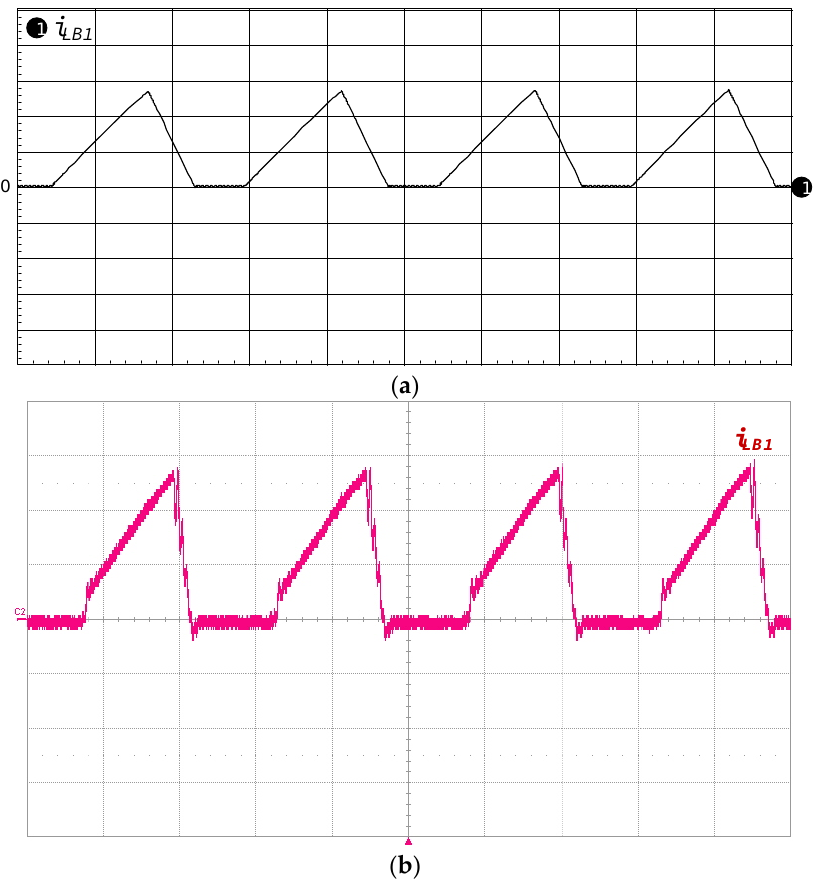
µ s/div. LB1 (1 A/div); time scale: 10